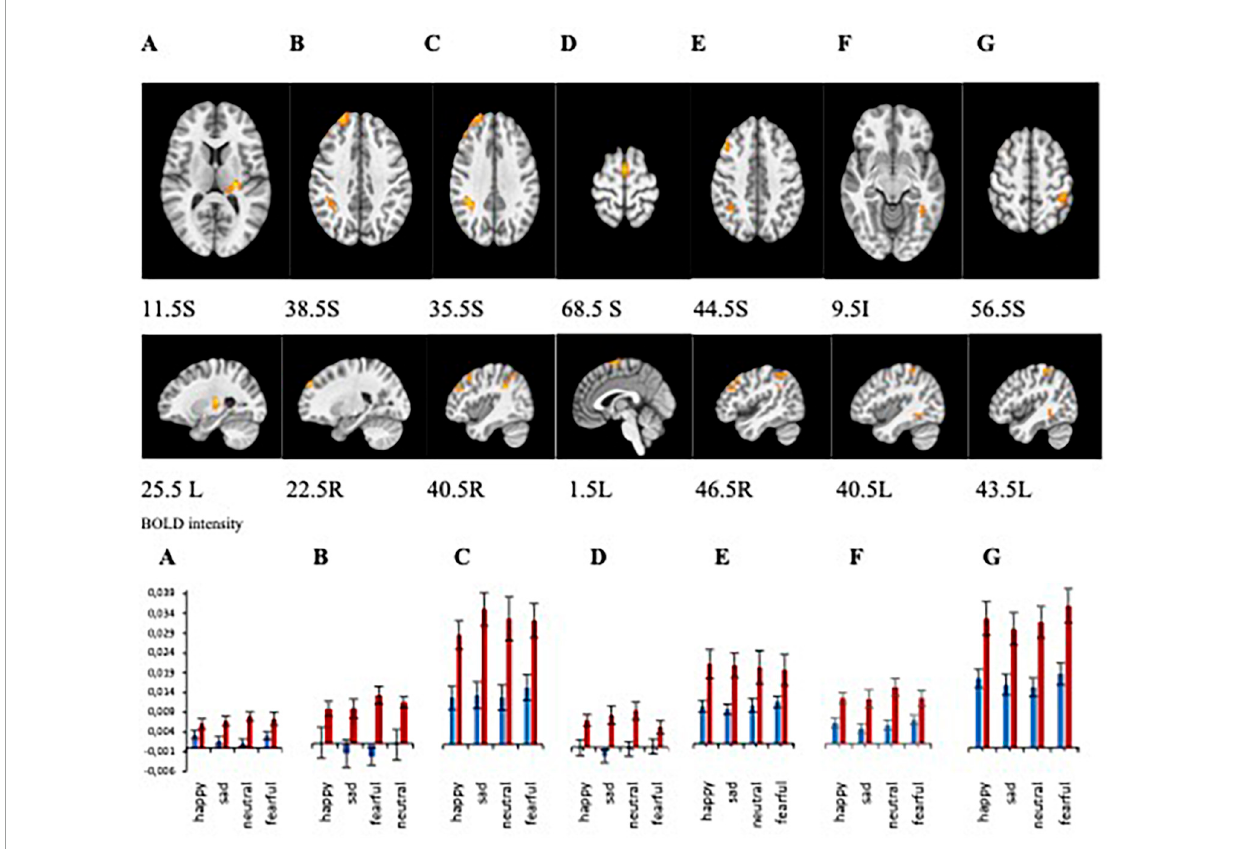
FIGURE4 (A–G) Brain regions that showed significant group differences between MDD and Healthy for presentations of happy, sad, fearful, and neutral faces [ (A) left thalamus/left claustrum, (B) right superior frontal gyrus, (C) right supramarginal gyrus, (D) left superior frontal gyrus, (E) right middle frontal gyrus, (F) right fusiform gyrus, (G) left inferior parietal lobule]. Plots for ROI that displayed a significant difference between BOLD intensity in MDD (blue) and HP (red) groups in the corresponding brain areas ( p <